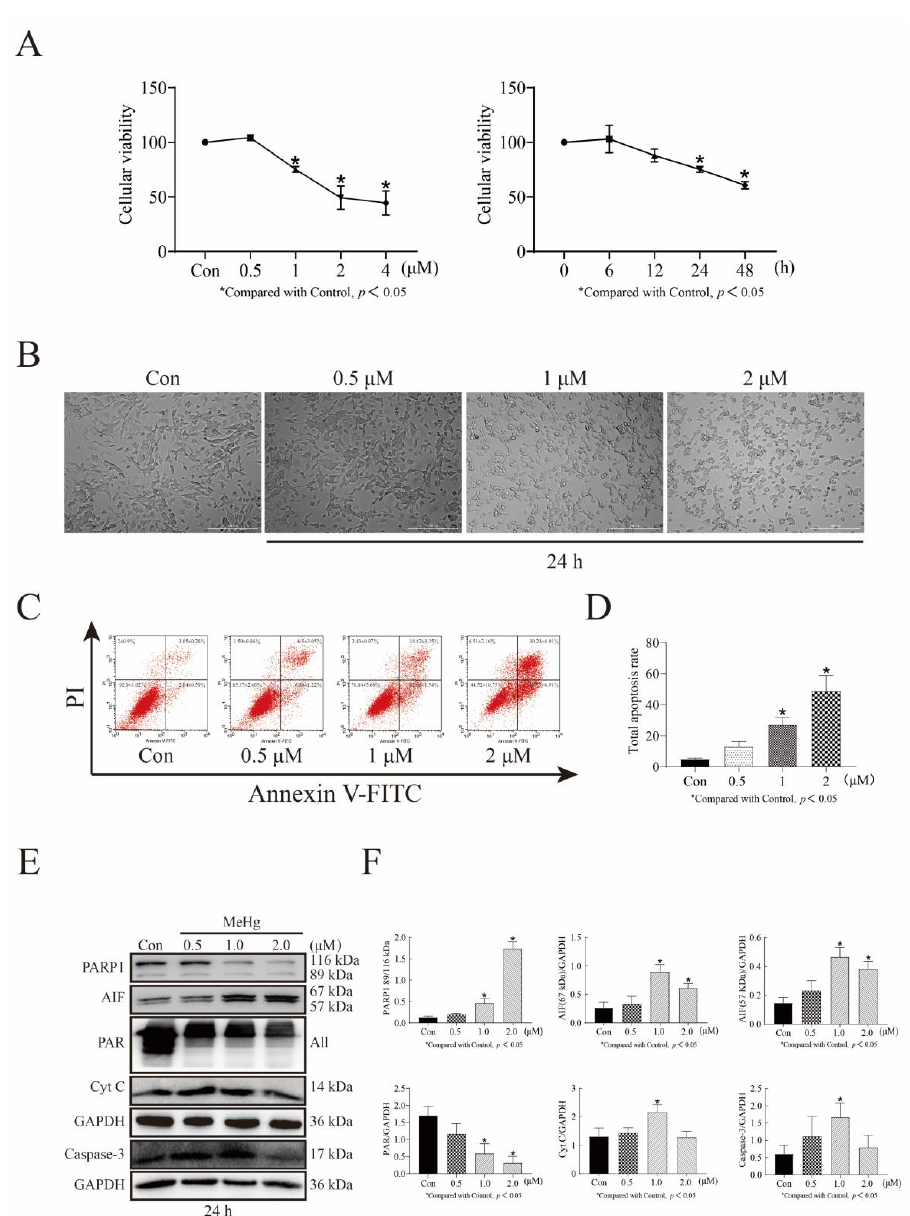
Figure 1. A cell damage model of MeHg was created by the treatment of SH-SY5Y cells with 0–4 µ M MeHg at indicated time intervals. ( A ) MTT assay showing cell viability of SH-SY5Y cells treated with 0–4 µ M MeHg for 6–48 h ( B ) The live cell workstation used to observe cell morphology of SH-SY5Y cells treated with 0–2 µ M MeHg for 24 h. ( C ) Flow cytometry detection of apoptosis in 0–2 µ M MeHg treated SH-SY5Y cells for 24 h. ( D ) GraphPad Prism 8.0.2 software was used to analyze the total apoptosis rate of SH-SY5Y cells treated with 0–2 µ M MeHg for 24 h. Statistical significance was determined using ANOVA; p < 0.05. ( E ) Western blot analysis of the protein expression levels of PARP1, AIF, PAR, Cyt C, and cleaved Caspase-3 in SH-SY5Y cells treated with 0–2 µ M MeHg for 24 h. ( F ) The Tanon-2500 fully automated digital gel image analysis system was used to analyze the net optical density of the Western blot strips. All values are represented as means ± SD ( n = 3). Superscript denotes a statistically significant difference between groups ( p < 0.05). Abbreviations: AIF, apoptosis-inducing factor; ANOVA, analysis of variance; Cyto C, cytochrome C; MeHg, methylmercury; MTT, 3-(4,5-dimethylthiazol-2-yl)-2,5-diphenyltetrazolium bromide; PAR, poly (adp-ribose); PARP1, poly (adp-ribose) polymerase 1; SH-SY5Y, neuroblastoma